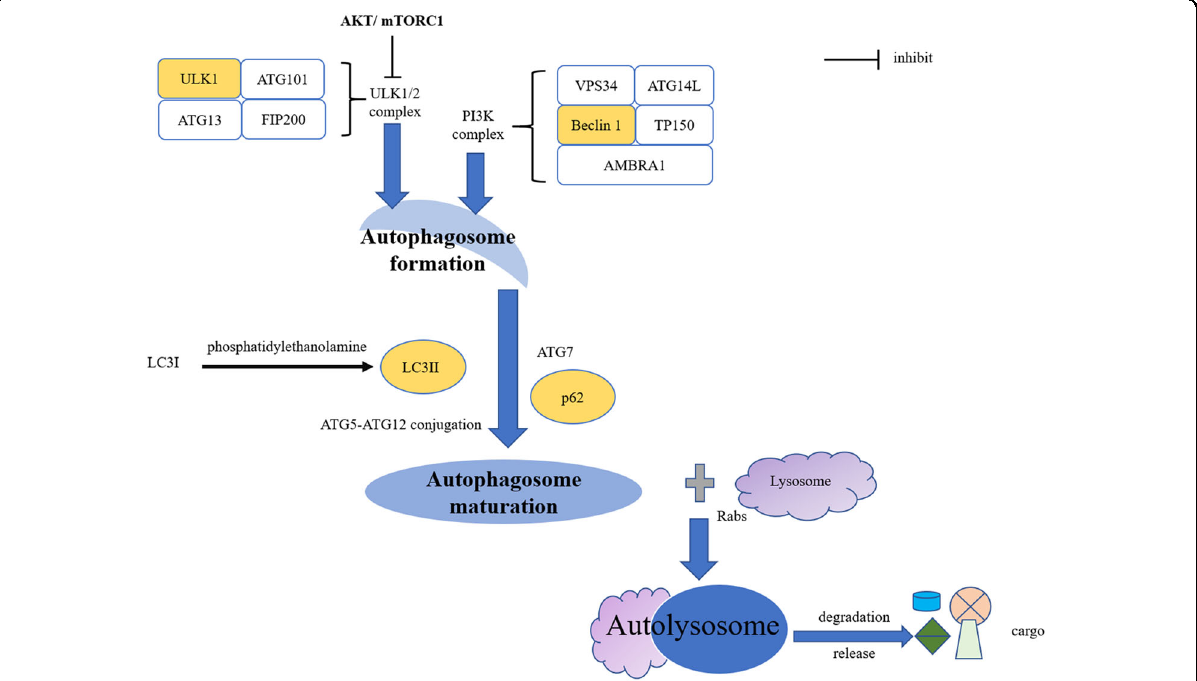
Fig. 1 Autophagy and autophagic proteins. Autophagy is roughly summarized as autophagosome formation, autophagosome maturation, and autolysosome formation. At the initial stage of autophagy formation, ULK1/2 complex is composed of ULK1, ATG101, ATG13, and FIP200. Subsequently, the PI3K complex with Beclin 1 as the core is added to promote the formation of the autophagosome. Then, LC3-I was transformed into LC3-II with phosphatidylethanolamine, ATG5 – ATG12 conjugation, and p62 recruitment to promote the maturation of autophagosomes. Finally, the autophagosome fuses with lysosomes under the mediation of Rabs and performs the degradation and release of